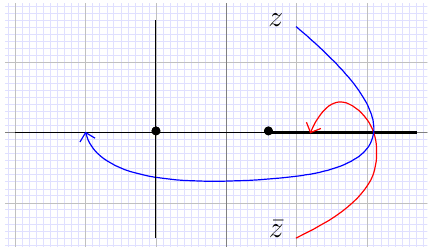
Figure 12 . z, z curves for the analytic continuation from the Euclidean for the hO 1 O 3 O 2 O 4 i ordering.